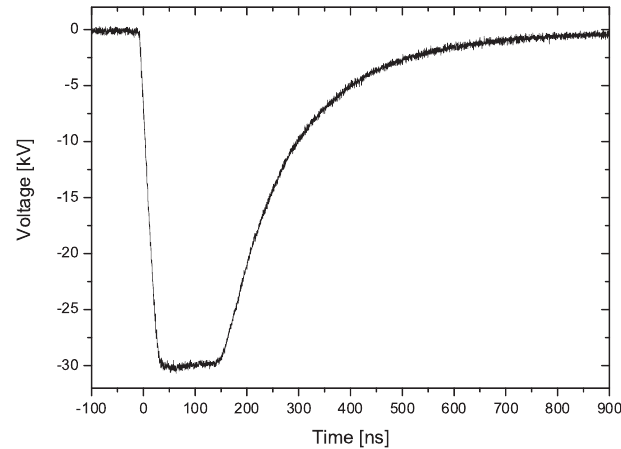
FIG. 7. Output signal V (cid:8) t (cid:9) of the switch measured using a Tektronix P6015A high voltage probe.